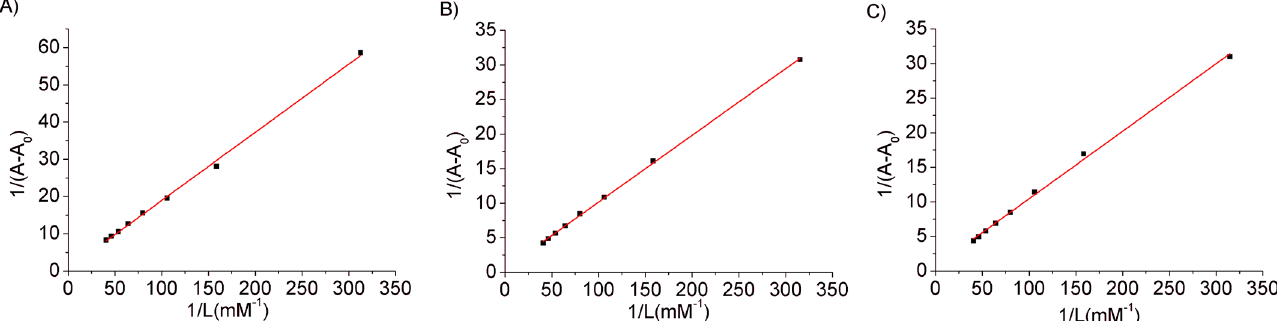
Fig 2. Binding constant determination. Plots of 1/(A-A 0 ) vs . 1/Isophorone concentration for DNA and their isophorone complexes. A 0 is the absorbance of DNA (at 260 nm) and A is the absorbance after isophorone addition.